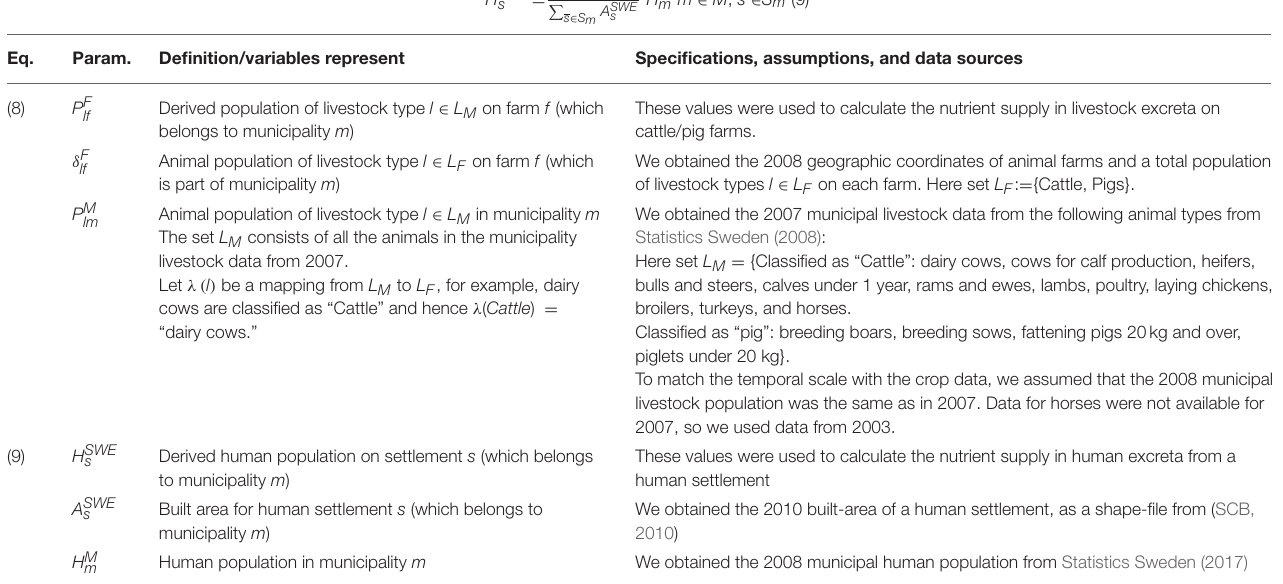
TABLE 2 | Equations, data, and assumptions used to transform Swedish municipal scale livestock and human populations to farm and human settlement scale populations. Spatial crop data were available at the field scale as more than one million agricultural blocks with the crop-specific cultivated area in each block (JBV, 2018a). We incorporated soil type and production region information into the blocks by combining the center point of a block with soil type grids and agricultural production region maps using ArcMap 10.3.1. We overlaid the municipal livestock data maps with the farm data map. There were no instances where there was a zero data value (of livestock or human) for a municipality but there was a value for a farm/human settlement and vice versa. We used Equation (8) to assign 2007 municipal livestock population to the location of cattle and pig farms. We used Equation (9) to convert the 2008 municipal human population into the human population at human settlements. δ F λ( l ) , P F lf =